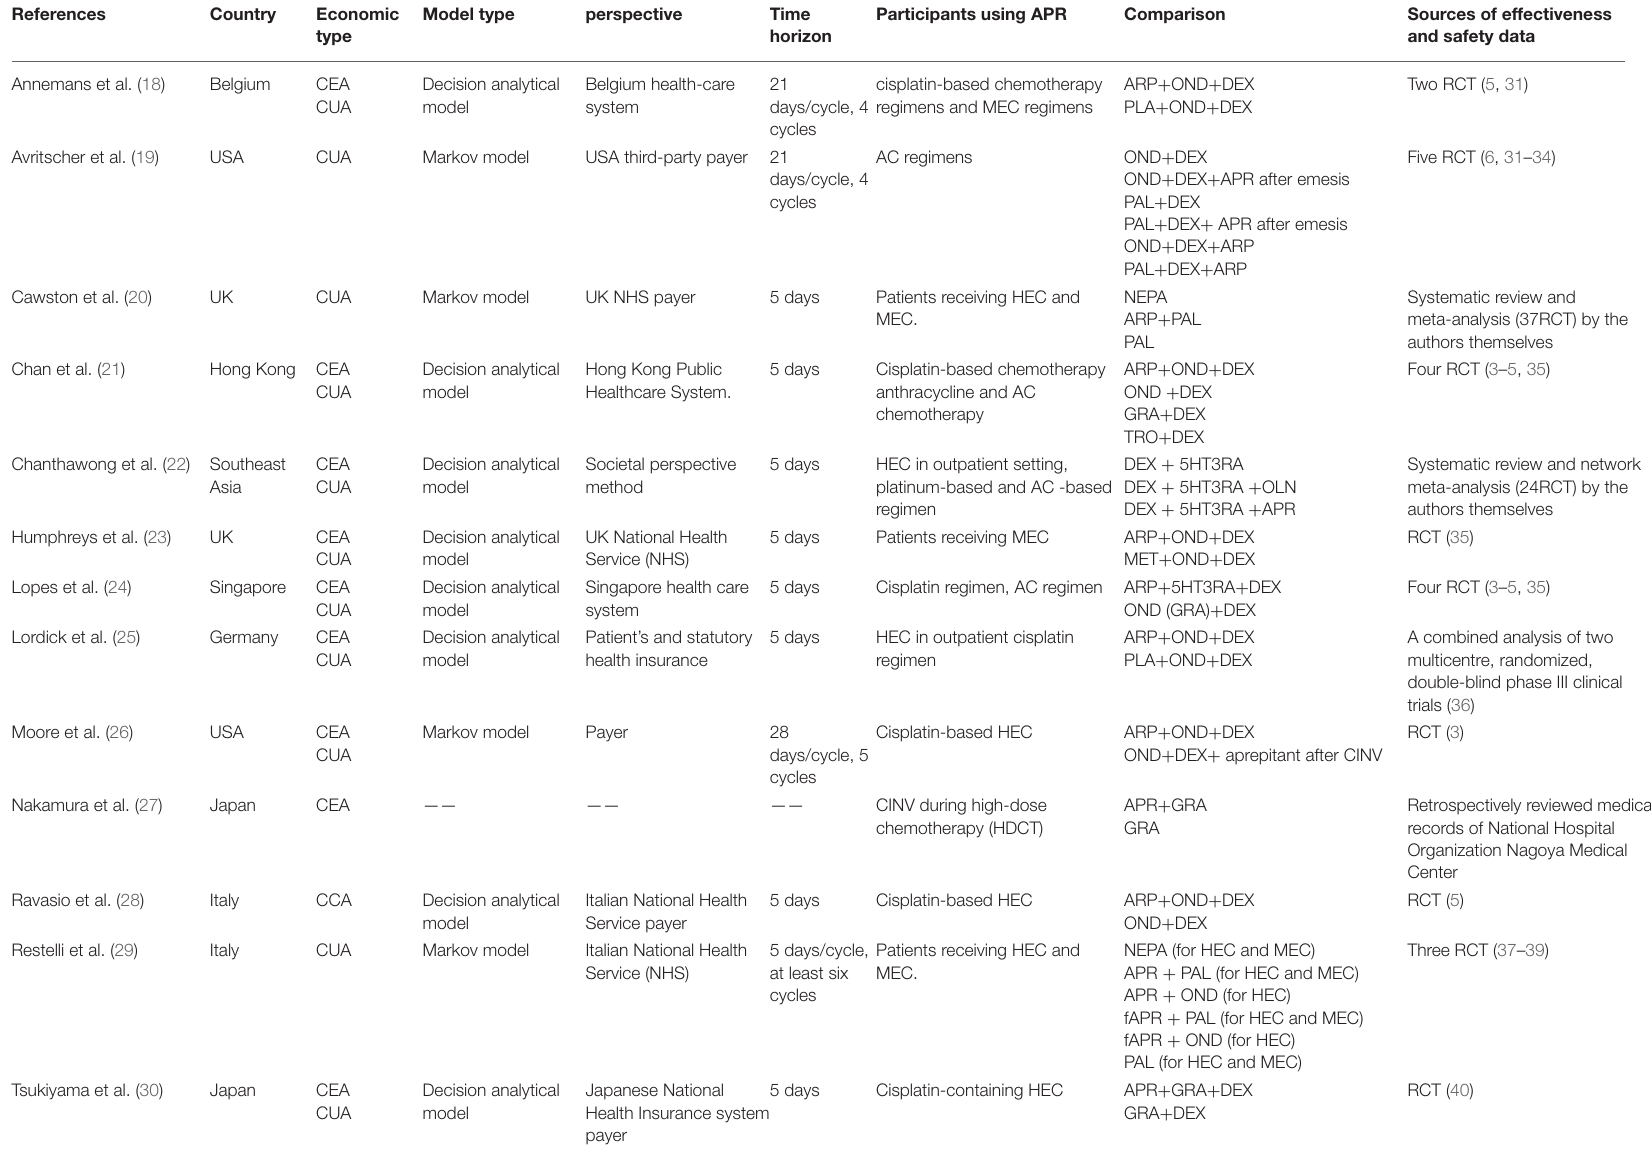
TABLE 1 | General characteristics of the included